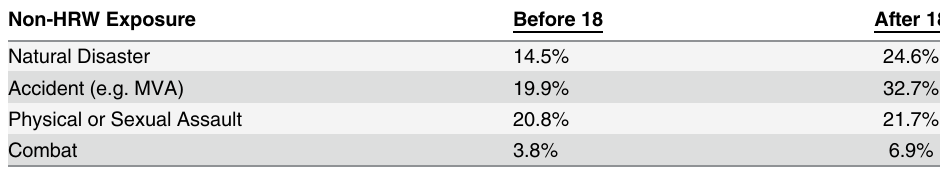
Table 2. Frequency and type of non-human rights work trauma exposure.